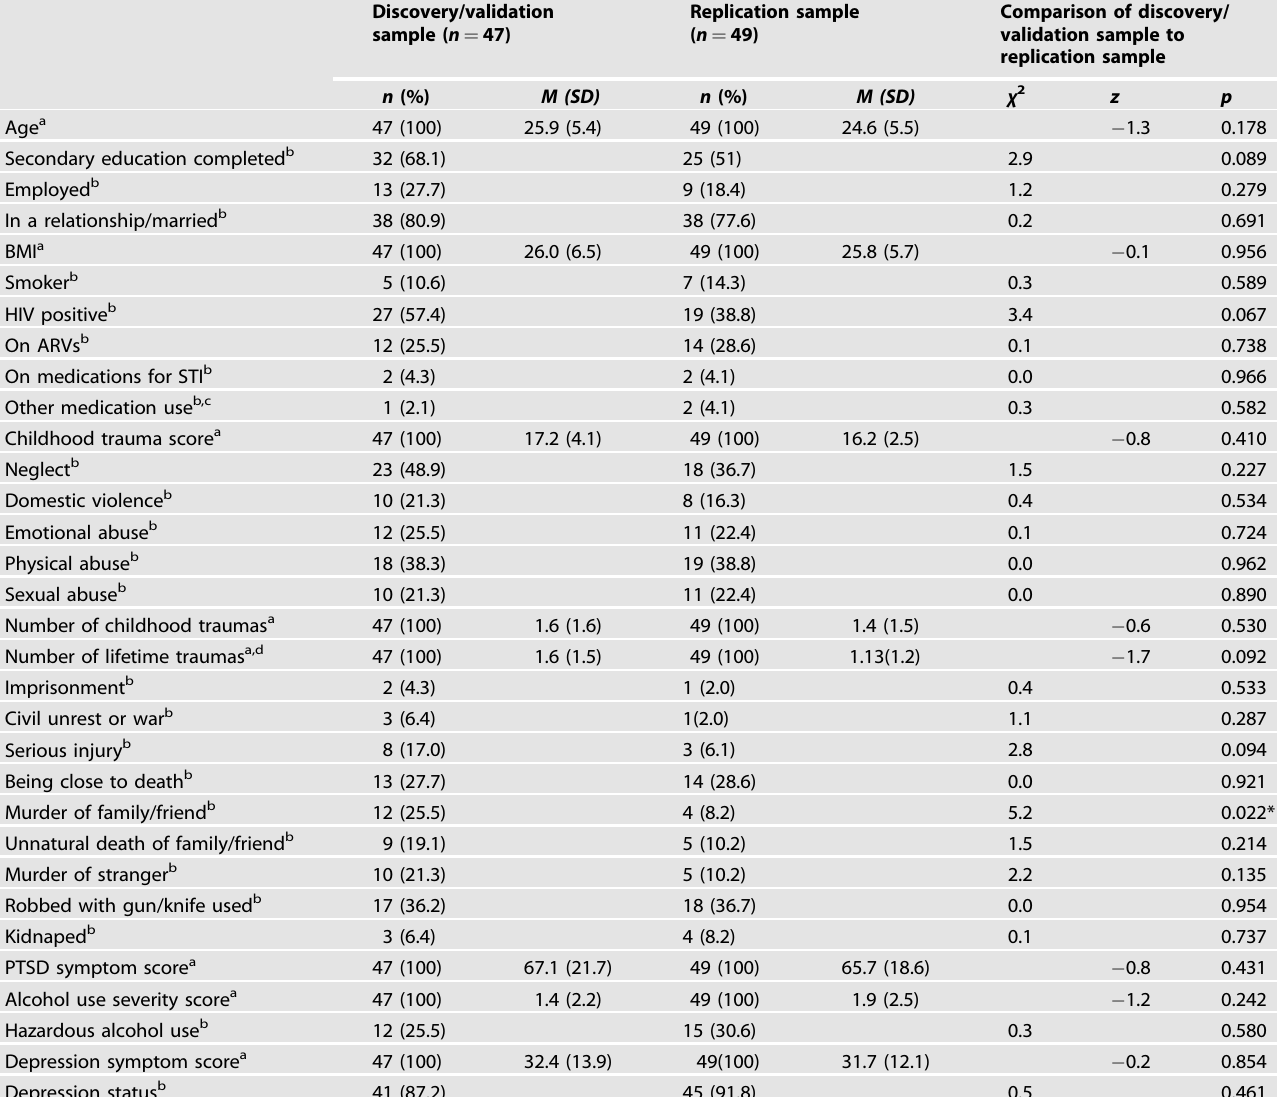
Table 2. Baseline demographic and clinical characteristics of the discovery/validation and replication samples.